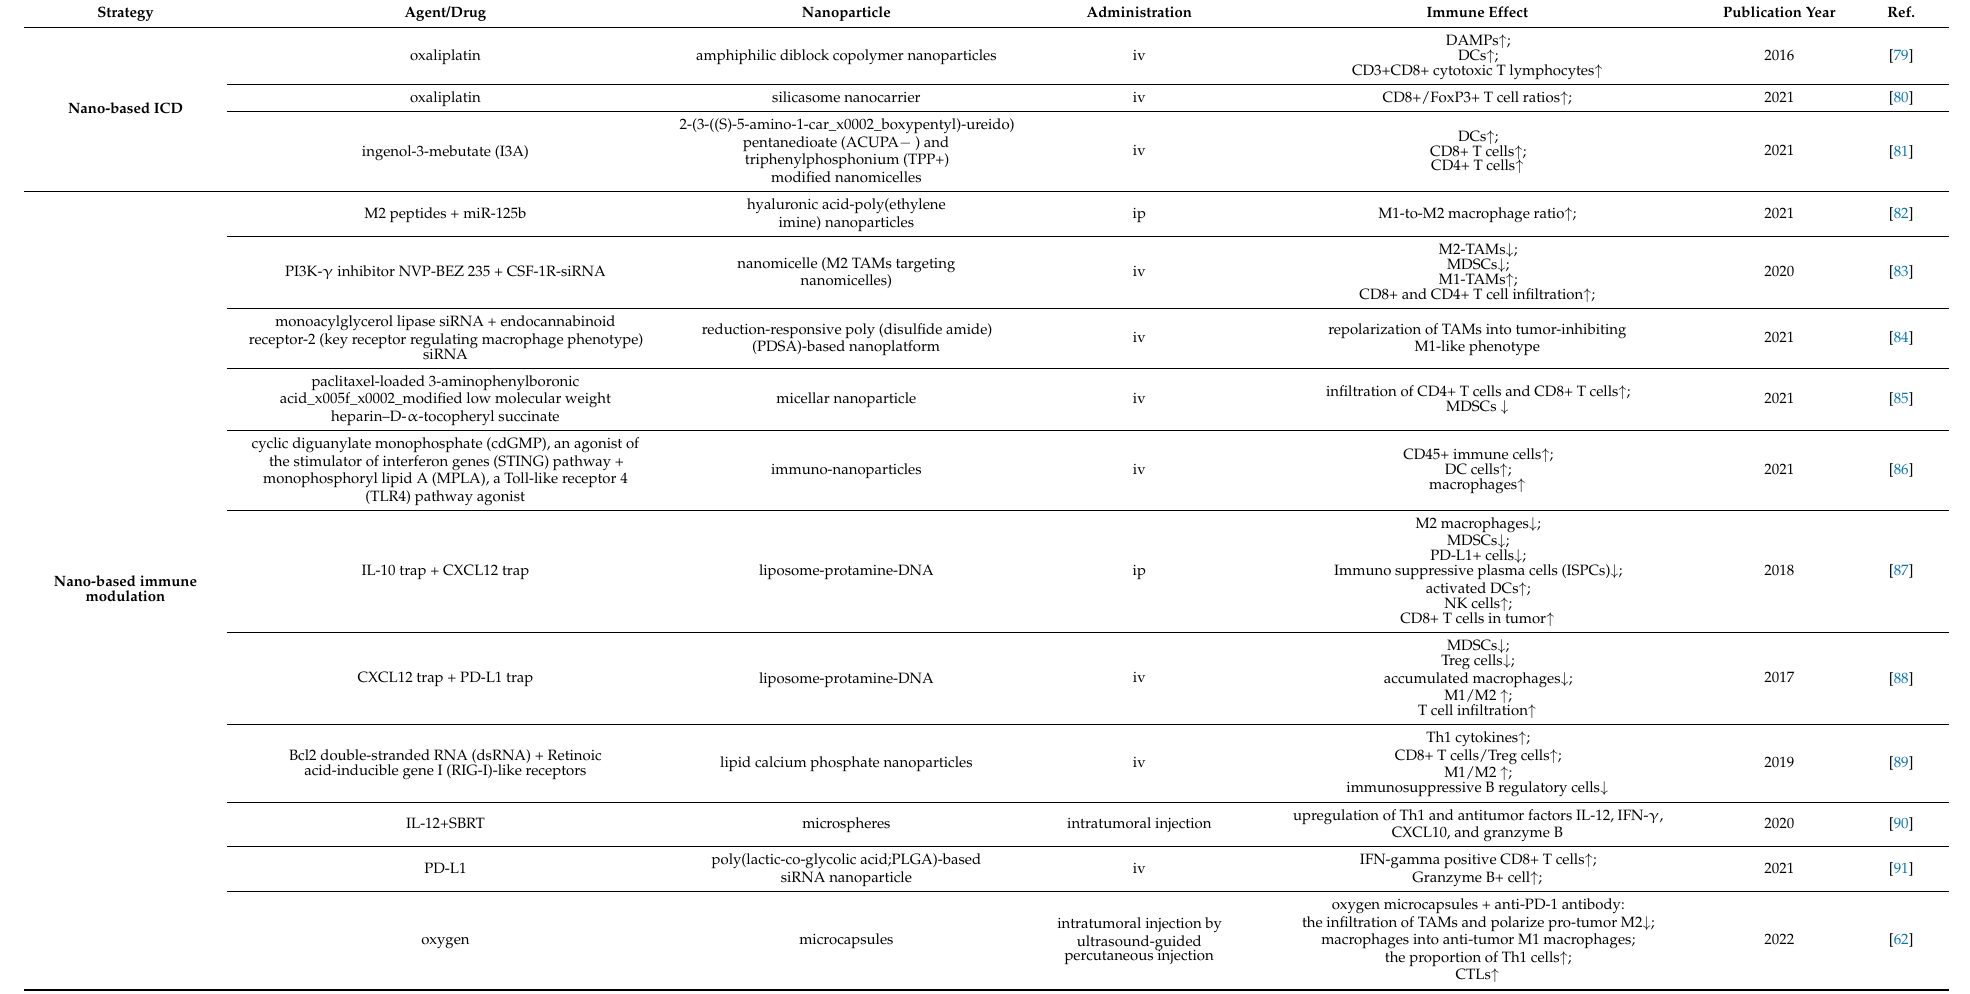
Table 2. Nanoparticle-based therapeutic strategies for enhanced PDAC